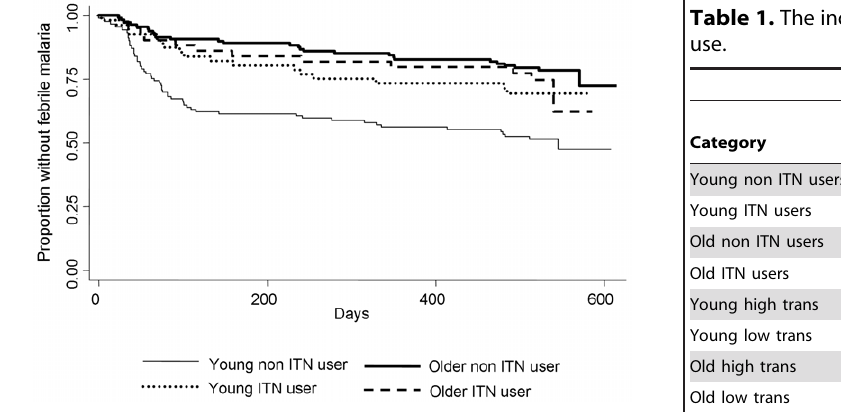
Figure 1. Survival plot of time to first episode of febrile malaria ( . 2,500 parasites per m l). Children are divided by age (in two categories) and by ITN use. P , 0.0001 by logrank.